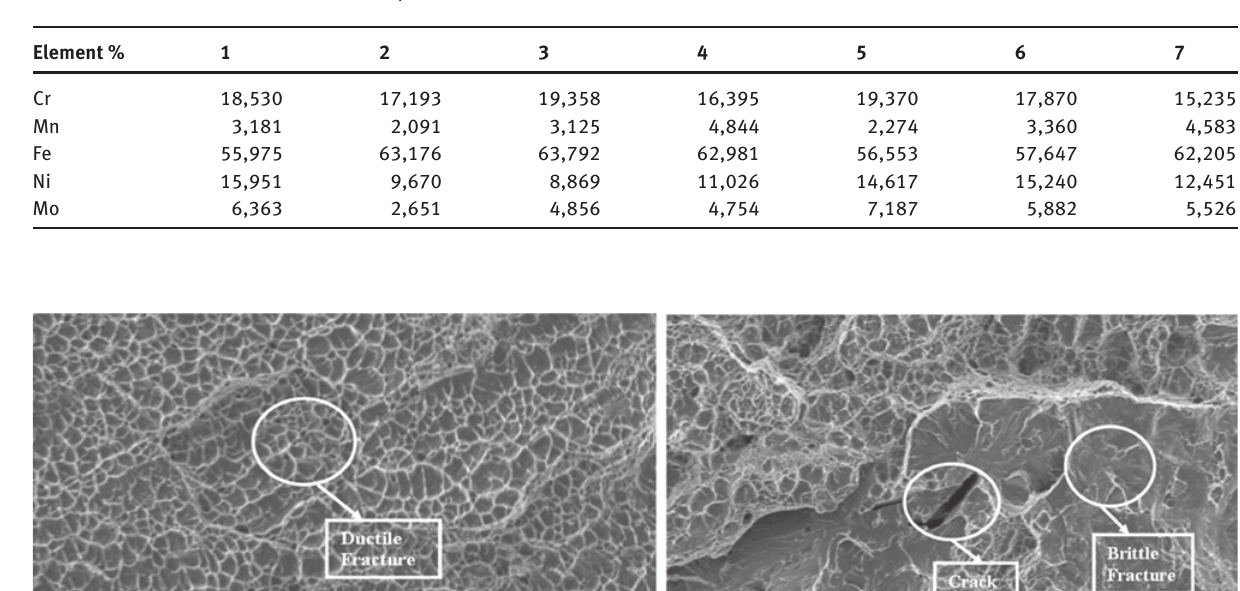
Table 6: EDS data of AISI 316 steel for sample 13